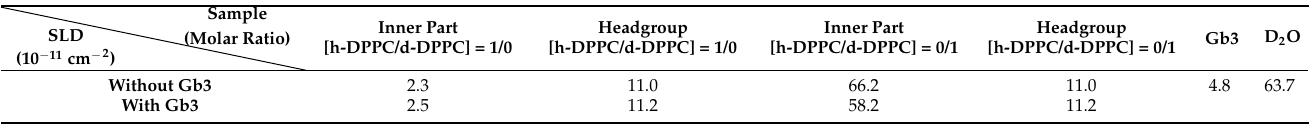
Table 1. The scattering length density used to determine contrast distribution profiles of the SUV bilayer structures for neutron scattering ( × 10 − 11 cm − 2 ). The SUV samples of Gb3 and DPPC mixture was prepared with [Gb3]/[DPPC] = 0.1/1. The SLD of hydrophilic head portions of h-DPPC and d-DPPC were identical, the high contrast comes from the hydrophobic tail portions of DPPC